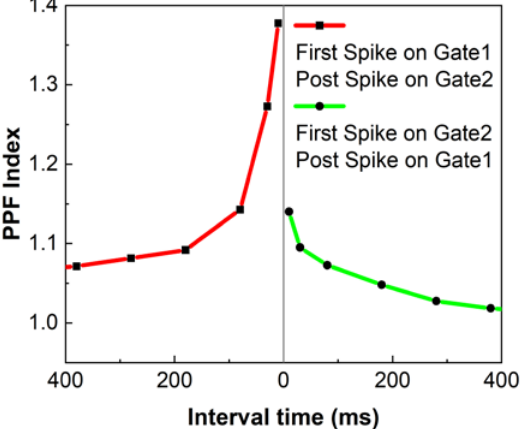
Figure 7. EPSC curves of the multi-gate EDLT when the consecutive pulses are added on the planar gate electrodes with ( a ) different distances to the channel, ( b ) different areas.